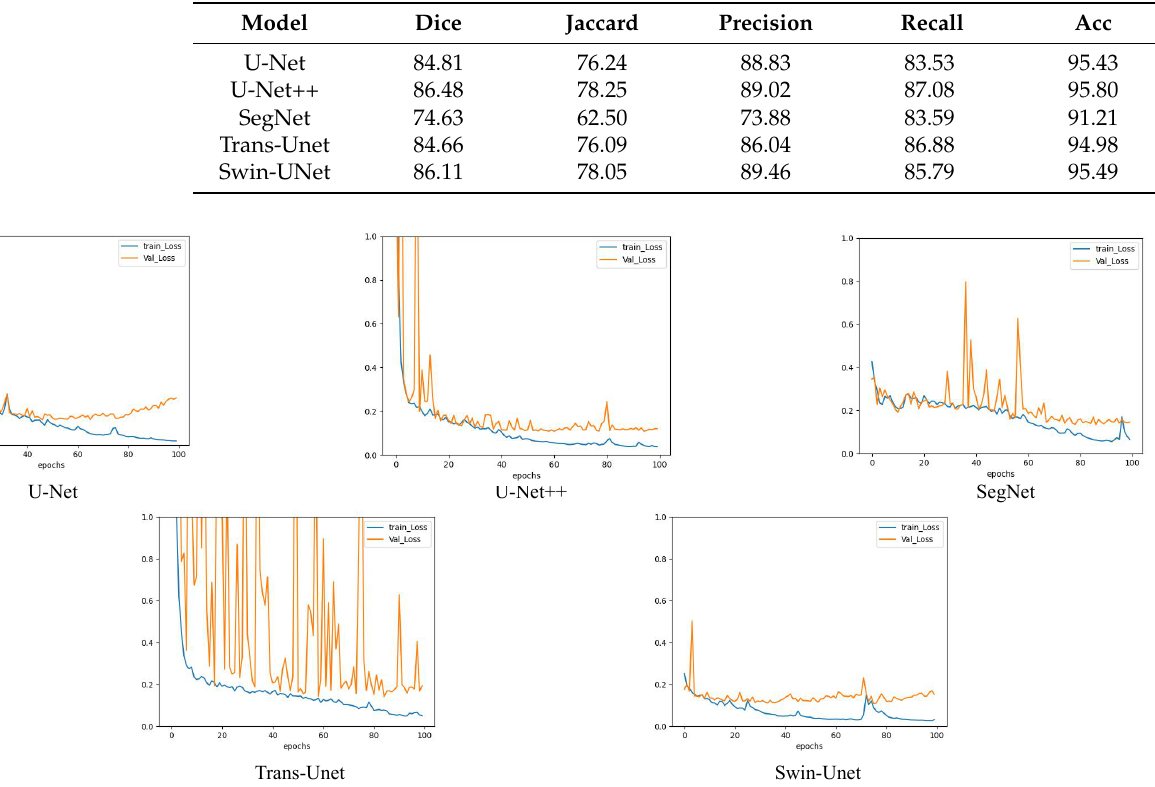
Figure 11. A comparison of the image segmentation results of the loss and accuracy curves of deep learning on pixel-level training and validation set of EMDS-6.